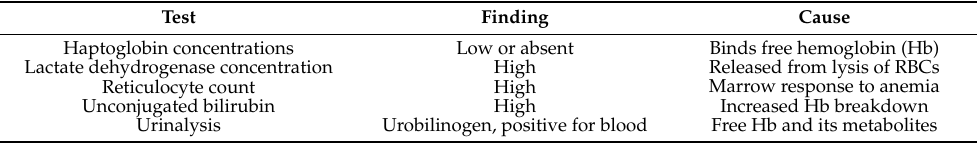
Table 2. Initial laboratory results found in a patient with PADH. (Adapted with permission from ref. [47], Copyright